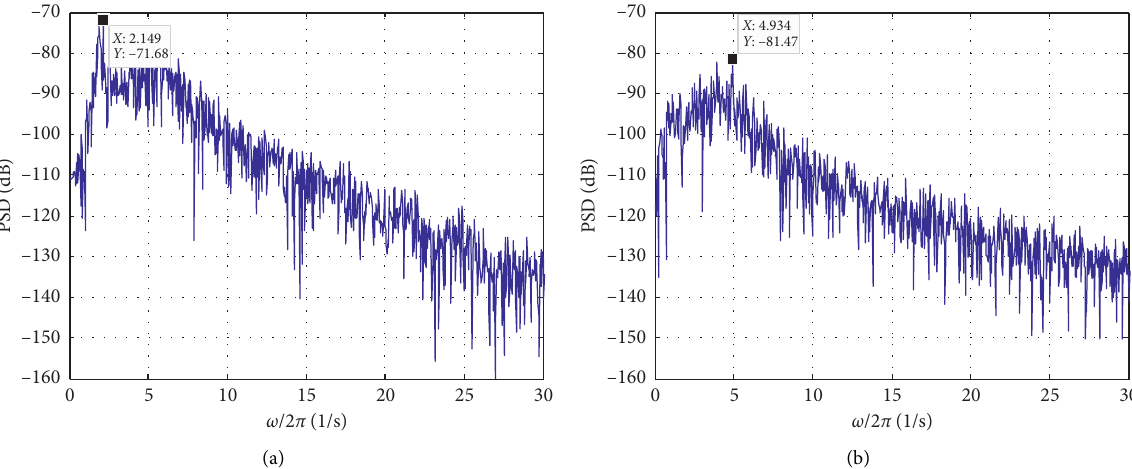
Figure 10: Power spectral densities of chaotified responses for (a) the nonlinear system [17] and (b) the QZS system, under the excitation at the frequency of ( ω /2 π ) � 15 . 9155.